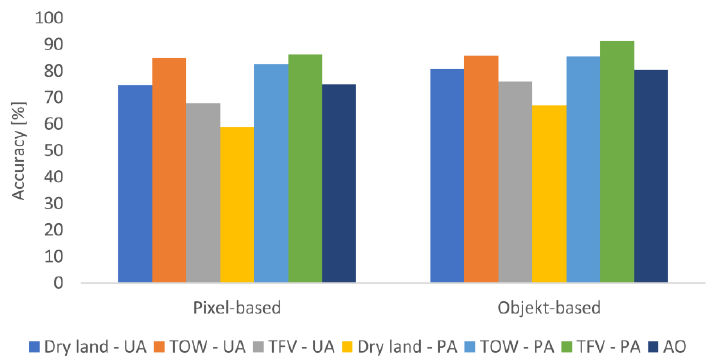
Figure 11. Accuracy assessment results for pixel- and object-based classification, which are generated by means of the time series approach.